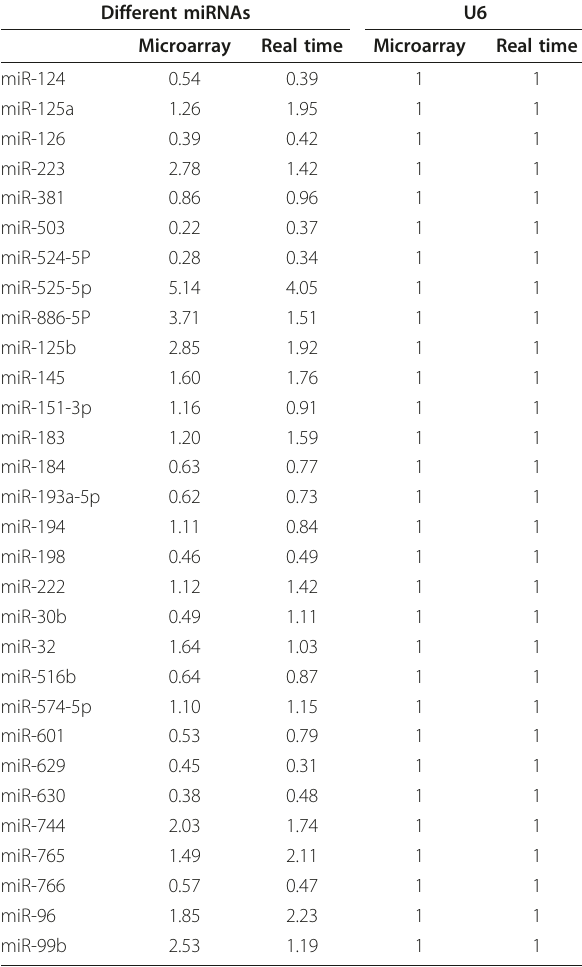
needed to elucidate the pathogenesis of different subtype Table 5 Some microarray data validation by qRT-PCR